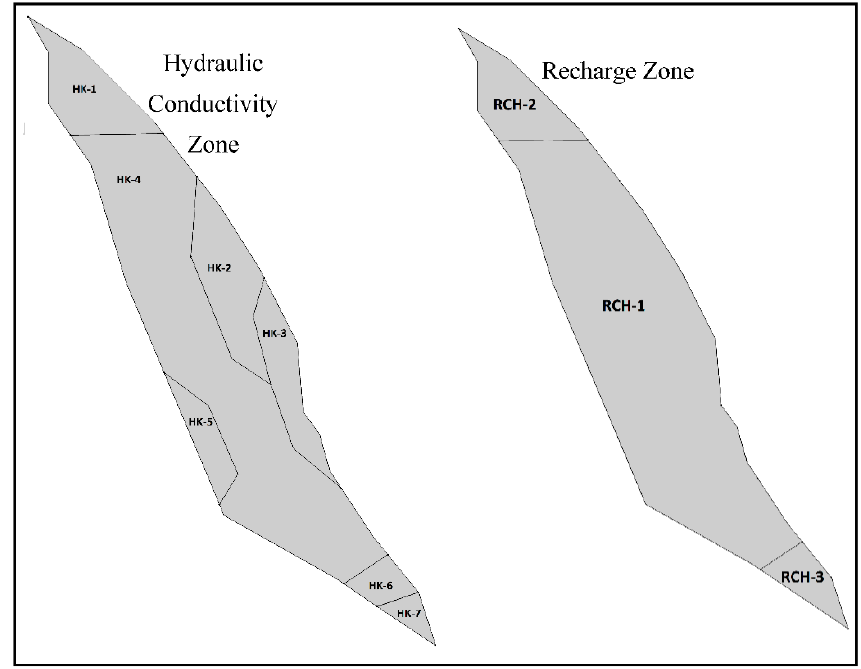
Figure 4. The divided zones of the hydraulic conductivity and natural recharge of the study area. The model was validated using well data for the transient condition. The calibrated models were used to estimate the effect of the suggested artificial recharge by the wells on the aquifer groundwater table with a focus on the surrounding area. Different scenarios were applied based on the hypothesis of groundwater pumping rates and artificial and natural recharge over the future period between 2022 and 2030. The results of the model were validated through the historical period 2016–2017 using realistic recharge rates drawn from the